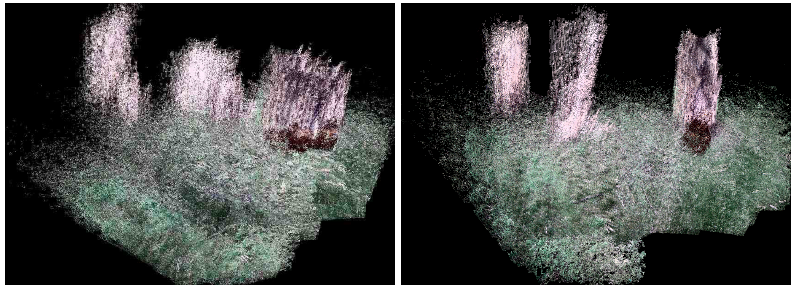
Figure 8. Outdoor mapping results before ( left ) and after ( right ) the pose-graph optimization showing more consistent 3D map after the